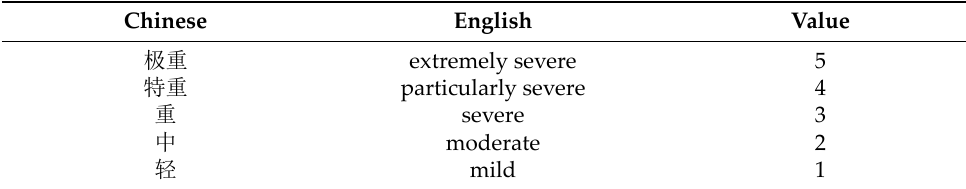
Table 3. Quantization of the attribute values indicating the